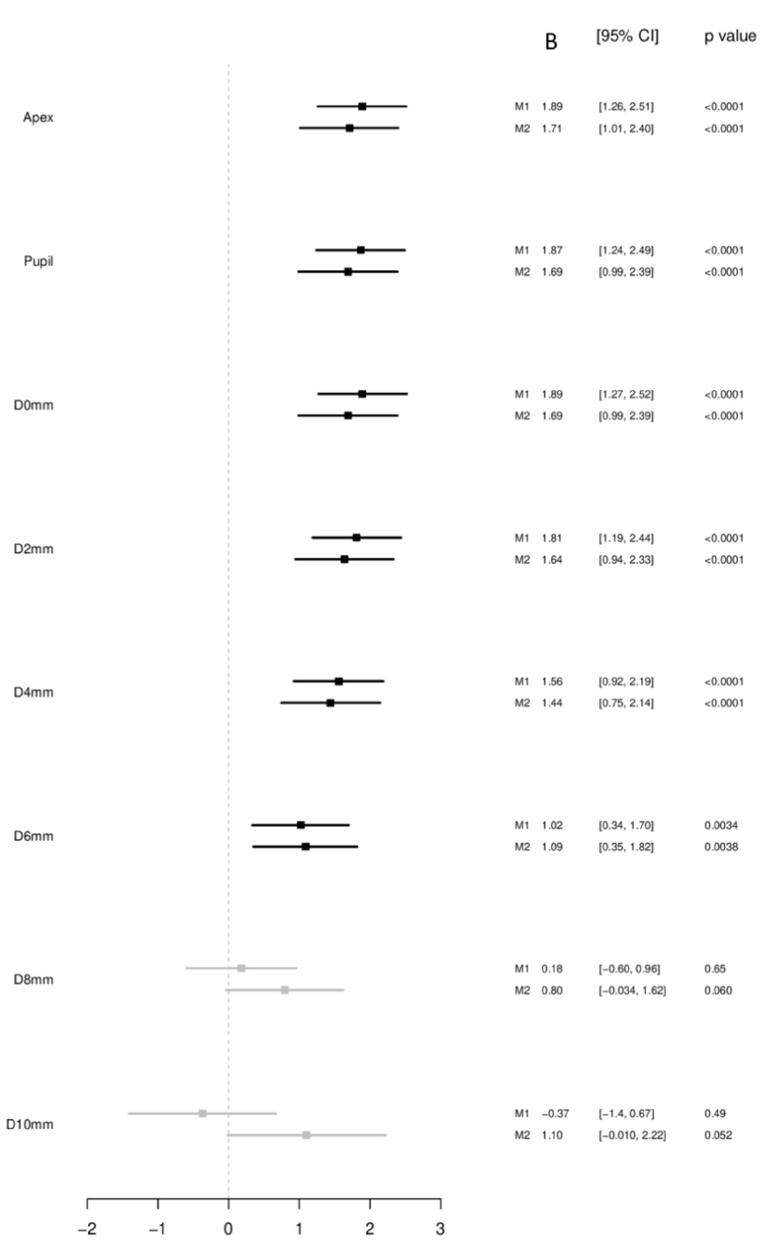
Figure 1. Scatterplot of birth weight with ( a ) corneal thickness in the apex, ( b ) corneal thickness in the pupil center, ( c ) minimal corneal thickness in the Gutenberg Health Study ( n = 5657).